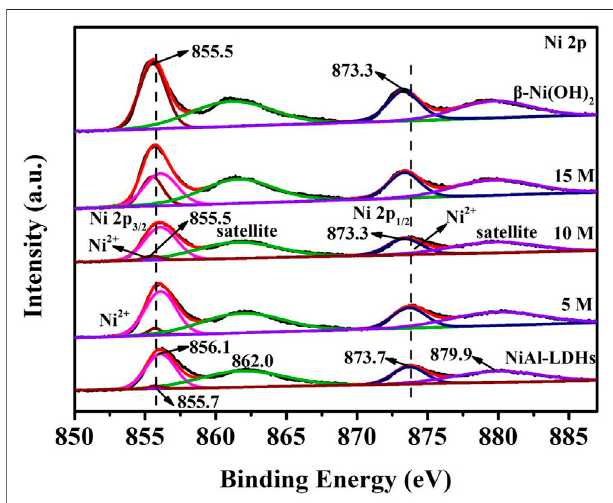
FIGURE 5 | Ni 2p XPS spectra of NiAl-LDHs precursor, the alkaline- etched samples in 5, 10, and 15 M KOH solution, and β -Ni(OH) 2 sample prepared by precipitation